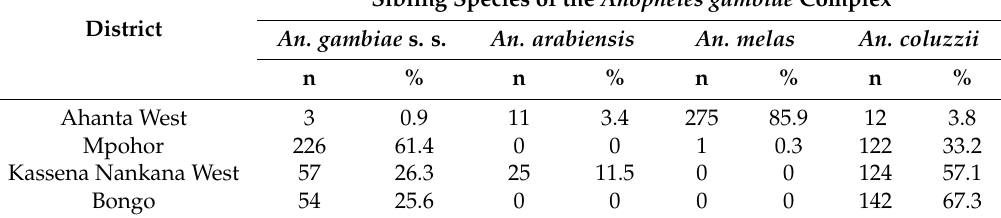
Table 3. Distribution of members of the An. gambiae complex in four study districts, Ghana, collected between July 2015 and July 2016. Sibling Species of the Anopheles gambiae Complex District An. gambiae s. s.